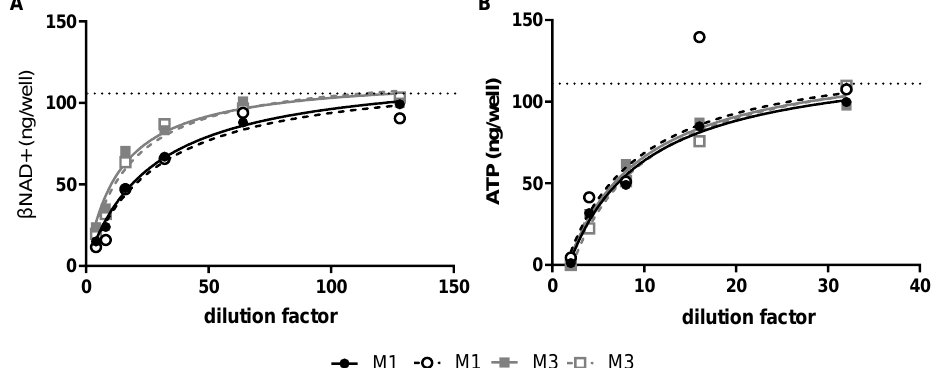
Figure 1. Exotoxins from GAS culture supernatants deplete skeletal muscle β NAD+ and ATP. Graphical representation of intracellular β NAD+ ( A ) or ATP ( B ) from cultured human SkMCs (~1 × 10 5 cells) after exposure to increasing dilutions of log-phase M1 or M3 GAS culture supernatants. Non-inoculated broth was used as a vehicle control (dashed line). In all graphs, data were fit by non-linear regression to find the 50% effective dilution (ED50) for each data set, i.e., two dilution series for M1 (closed or open circles with black solid or dashed lines that represented the curve fit) and two dilution series for M3 (closed or open squares with grey solid or dashed lines that represented the curve fit). Symbols represent each individual value. ( A ) Intracellular β NAD+ was measured by cycling assay after 1 h of exposure to culture supernatant. For M1, ED50s are 26 and 28 for solid and dashed lines, respectively. For M3, ED50s are 14 and 16 for solid and dash lines, respectively. ( B ) ATP was quantitated by firefly luciferin/luciferase luminescence assay after 2 h of exposure to culture supernatant. For M1, ED50s are 6 and 8 for solid and dashed lines, respectively. For M3, ED50s are 3 and 12 for solid and dash lines, respectively.